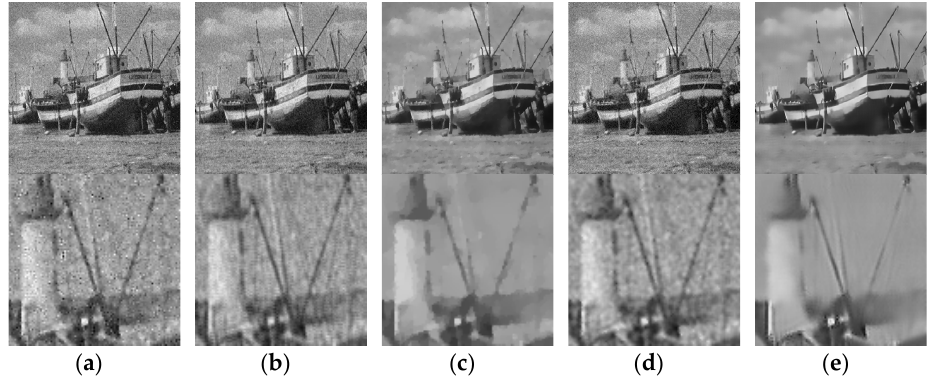
Figure 9. De-noising results for Boat image with AWGN of σ = 30 ( a ) WF ( b ) 2DACSWF ( c ) SBITV ( d ) FMGF ( e ) Proposed method.